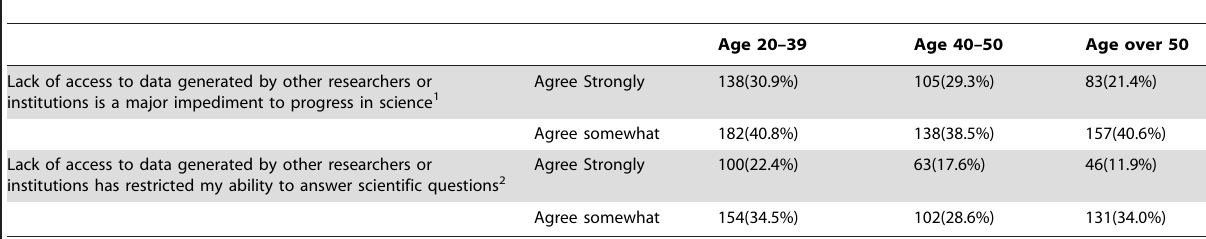
Table 24. Data reuse by age